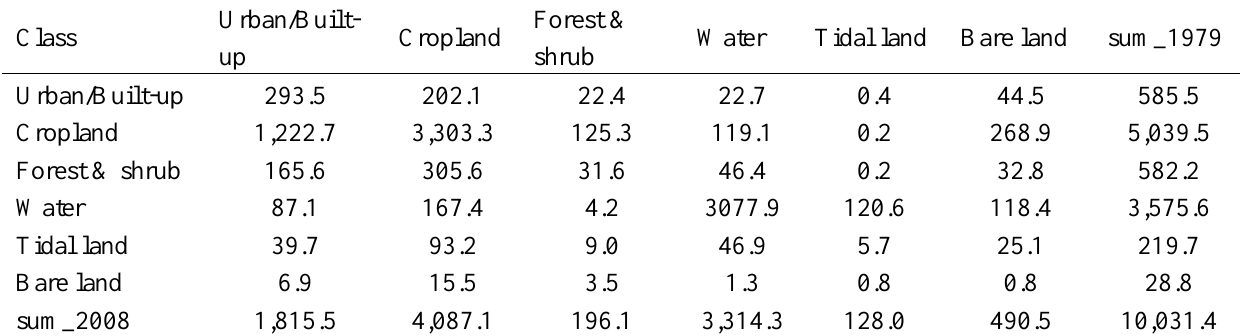
Table 8. Land use transformation matrix in 1979–2008 (unit: km 2